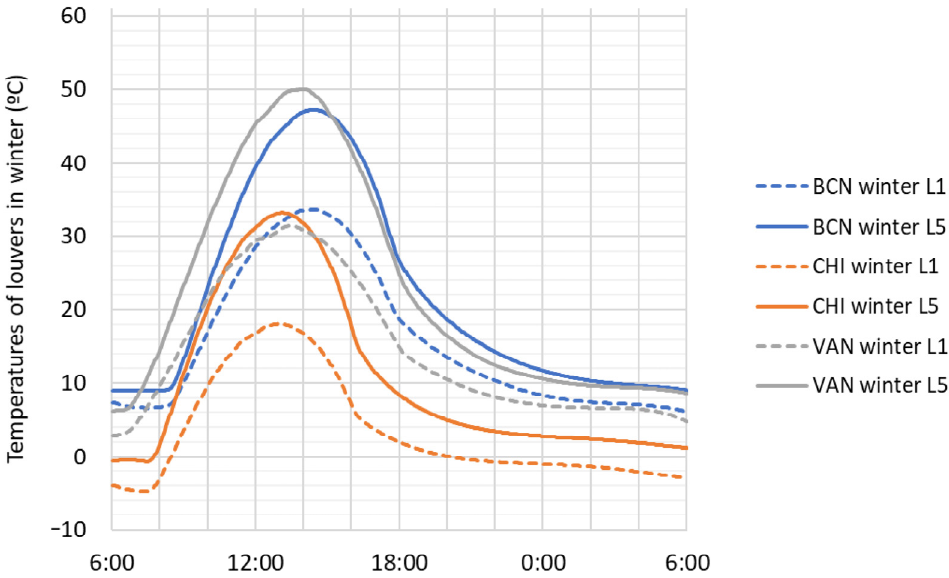
Figure 16. Temperature of the louvres on each winter day calculated.